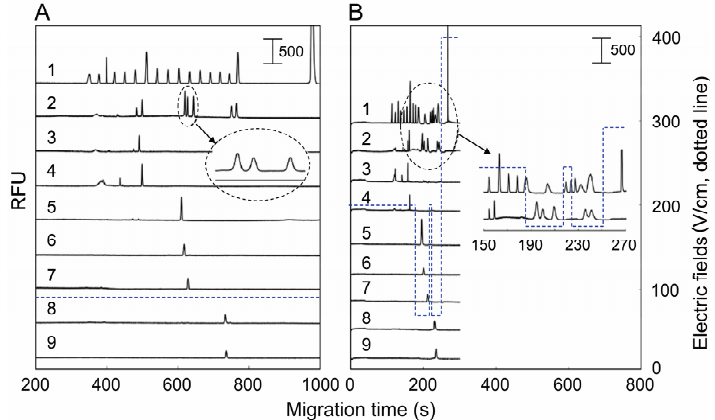
Figure 5. Representative electropherograms obtained by multi-channel microchip electrophoresis of rice knockout DNA sample sunder ( A ) constant field strength (CFS) and ( B ) programmed field strength gradient (PFSG). Reprinted with permission from